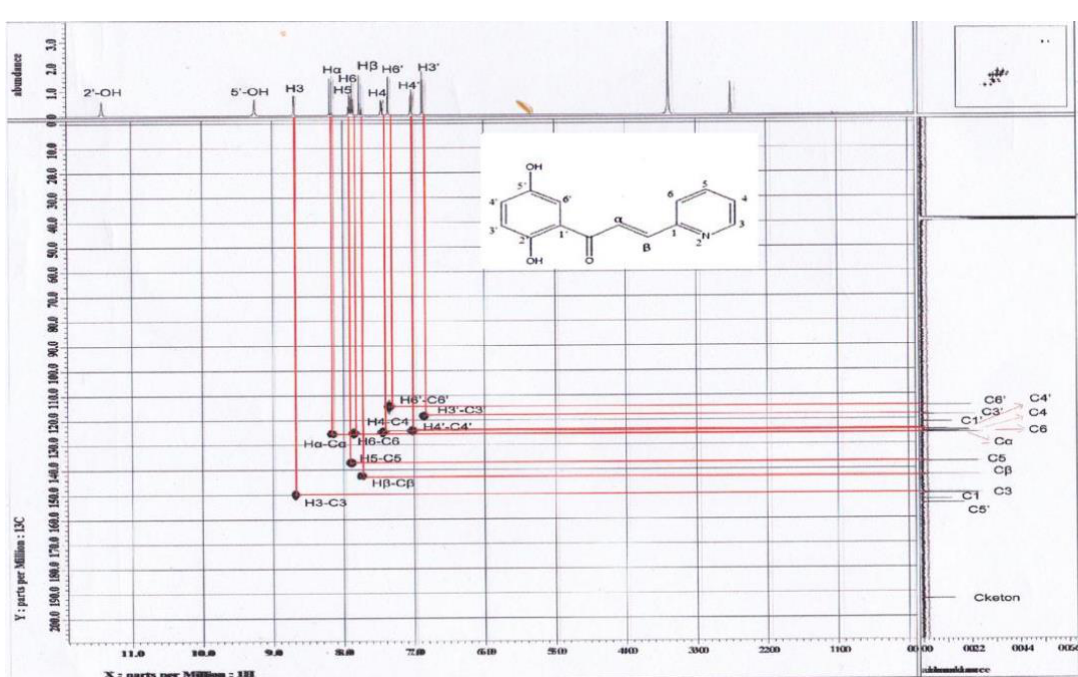
Figure 9. C-NMR spektrum